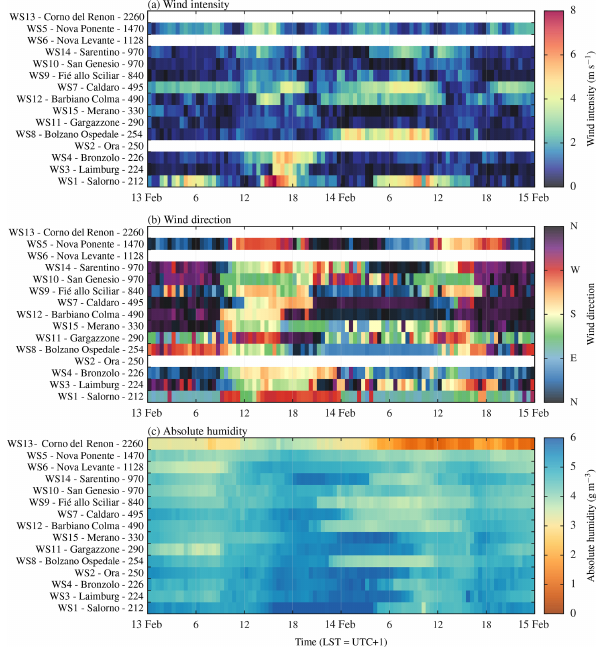
Figure 7. Time–height distribution of the thermal field (a) and of the wind fields measured by the sodar (b–c) and by the Doppler wind lidar (d–e) inside the Bolzano